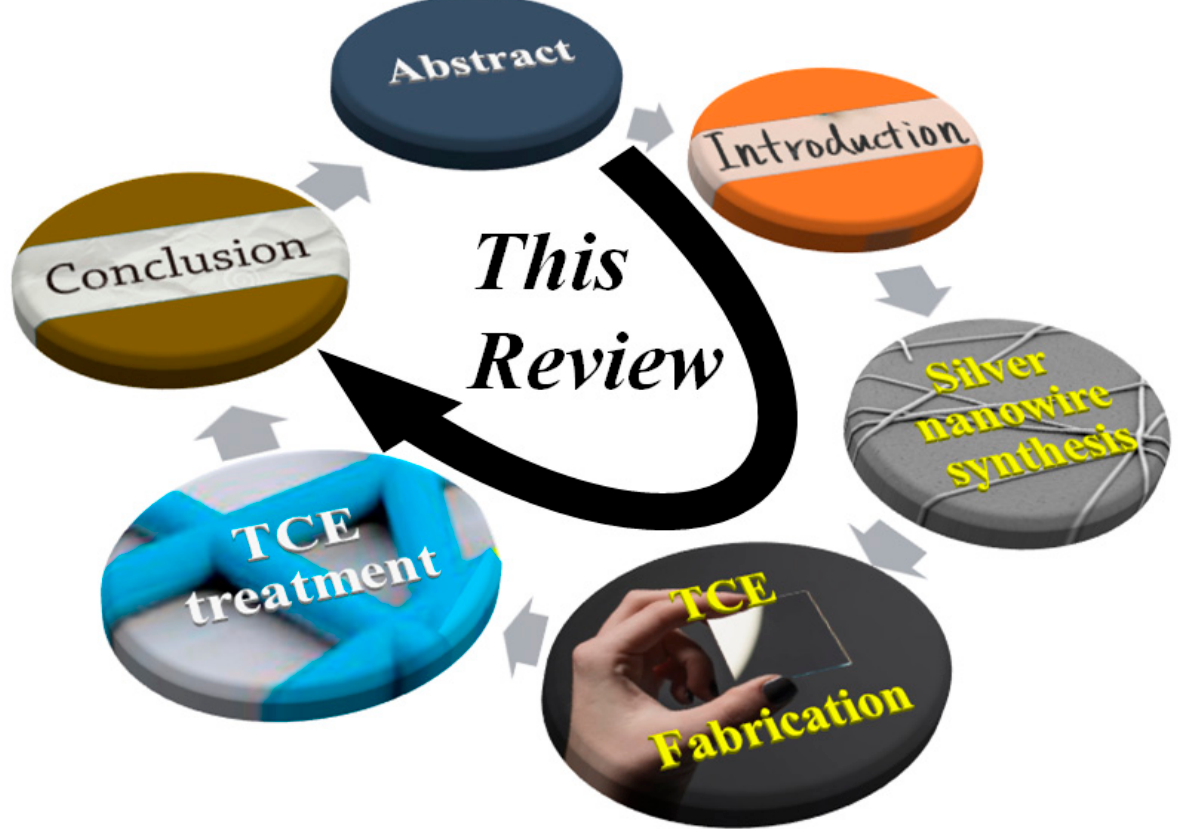
Figure 1. Schematic illustration of the review outline.